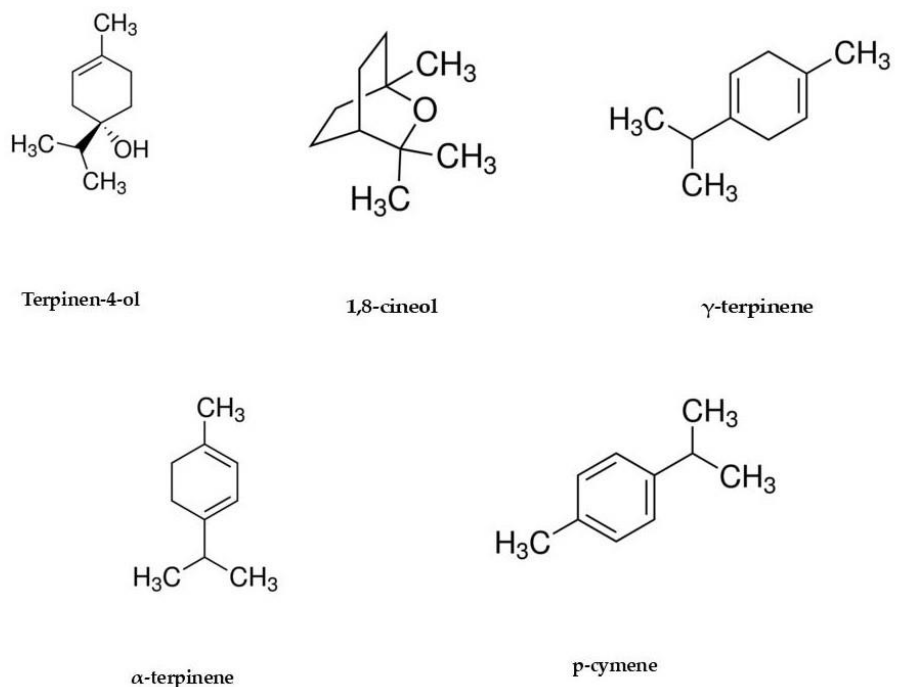
Figure 2. Chemical structures of the isolated